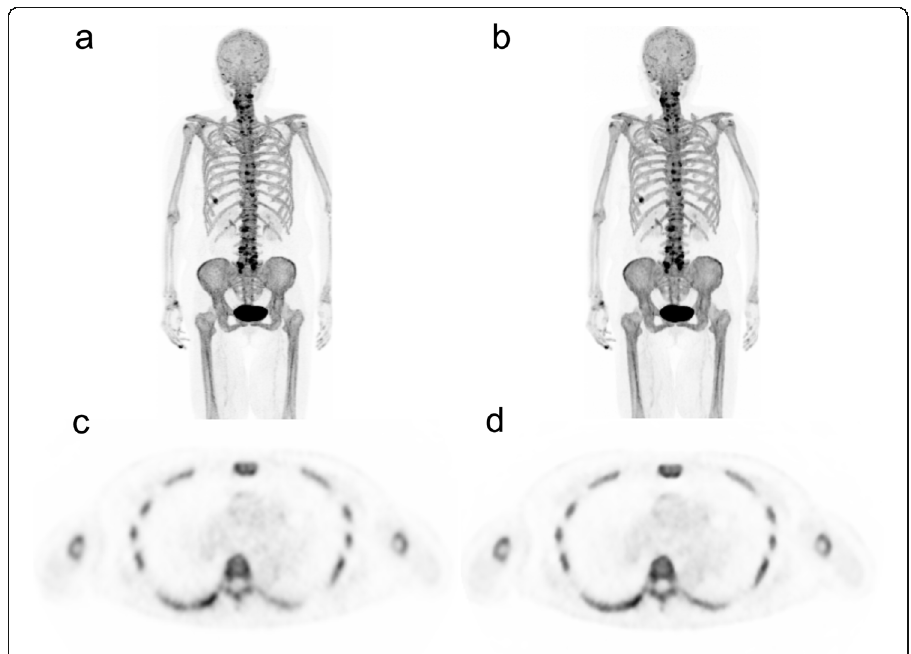
Fig. 7 18 F-NaF PET images of a 77-year-old female (weight 63 kg). Maximum intensity projection (MIP) and axial PET images reconstructed by a , c OSEM (2 iterations) and b , d BPL ( β value, 400), respectively.